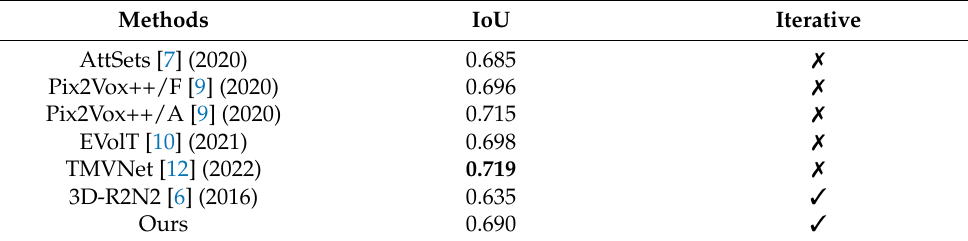
Table 1. Comparison of the IoU obtained on 8 randomly selected views from the R2N2 dataset. We take the mean for all objects in the test set. Performance numbers are taken from the referenced publications. The highest obtained IoU is highlighted in bold. The Iterative column indicates whether a method is capable of processing images iteratively. Our method achieves the best IoU when iterative processing is required.